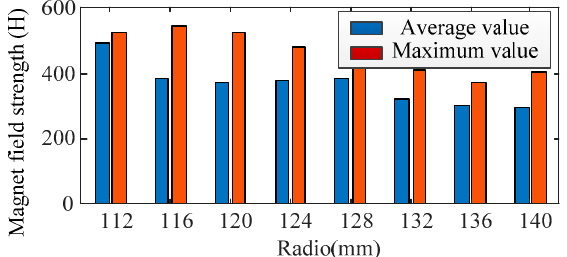
Figure 9. Maximum and average values of magnetic field strength due to the fringe effect with